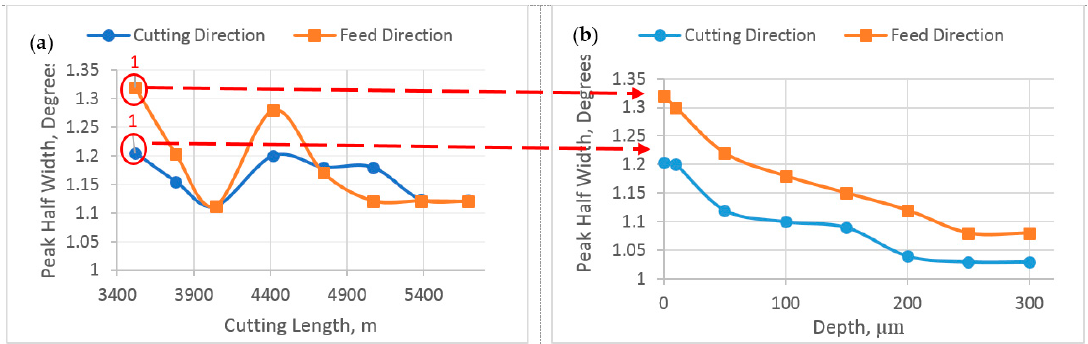
Figure 10. ( a ) Relation between Peak Half width and cutting length during steady state zone; and ( b ) in depth peak half width profiles in cutting and feed directions for the first point of steady state zone.